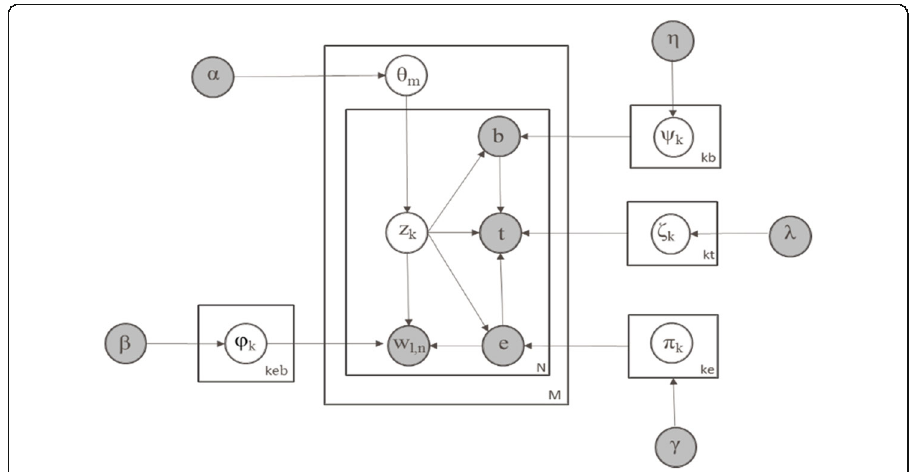
Fig. 2 Time Information-Emotion Behavior Model (TI-EBTM)